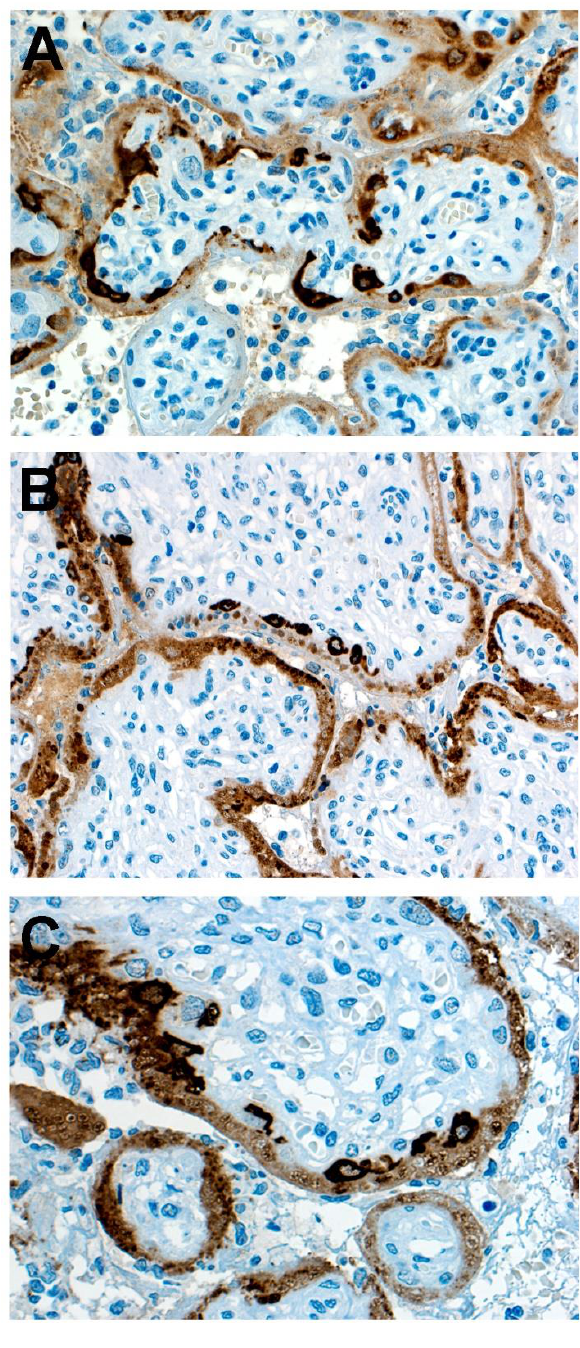
Figure 3. ( A ). Staining with antibody to SARS-CoV-2 nucleocapsid protein is positive (brown) in the trophoblast layer of chorionic villi. The outermost syncytiotrophoblast demonstrates diffuse light brown staining in most villi, and beneath it, dark brown staining of large individual cytotrophoblast cells is present. Note the greater intensity of positive staining in the cytotrophoblast compared with the syncytiotrophoblast. ( B , C ). These images demonstrate positive staining cytotrophoblast cells aligned linearly immediately beneath the syncytiotrophoblast, creating a “string of pearls” appear- ance. As can be seen in all 3 images, some chorionic villi exhibit multiple cytotrophoblast cells that are positive for viral nucleocapsid protein, while other villi have positive staining of only the syn- cytiotrophoblast. Antibody to SARS-CoV-2 nucleocapsid protein, ×20.